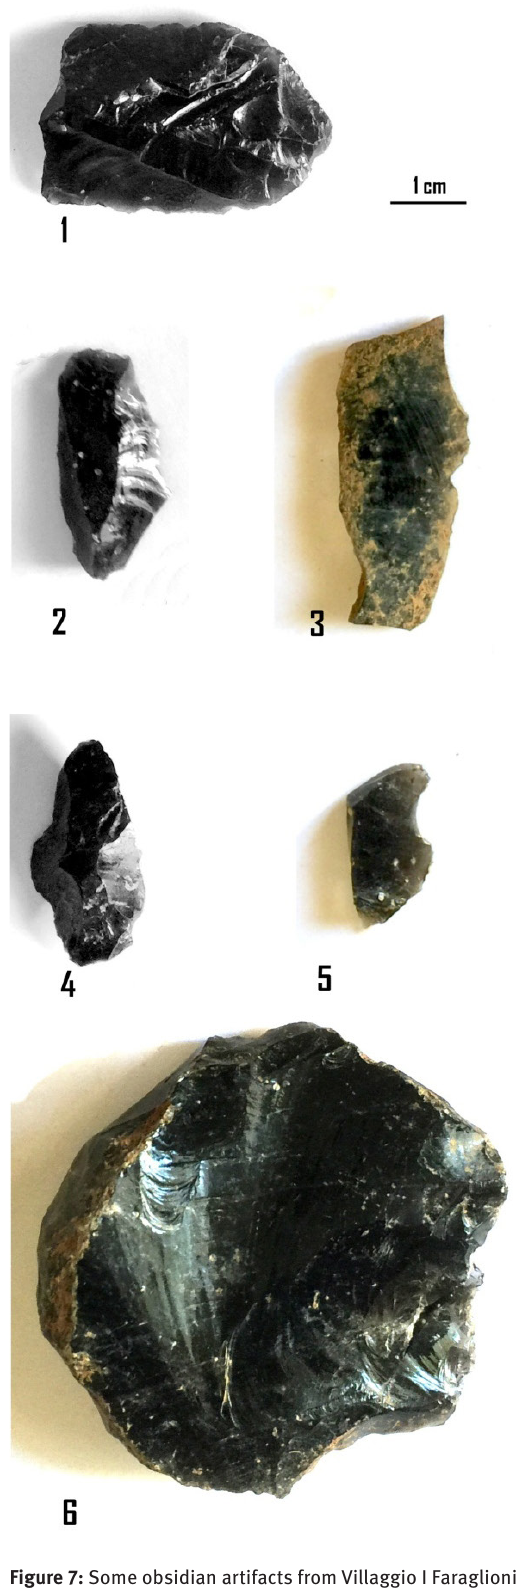
Figure 7: Some obsidian artifacts from Villaggio I Faraglioni. 1=USF29070, Lipari-Gabellotto, wide blade; 2=USF29084, Lipari-Gabellotto, wide blade; 3=USF29089, Lipari-Gabellotto, blade; 4=29001, Pantelleria-Balata dei Turchi, waste; 5=29054, Lipari-Gabellotto, waste; 6=USF28955, Lipari-Gabellotto, big